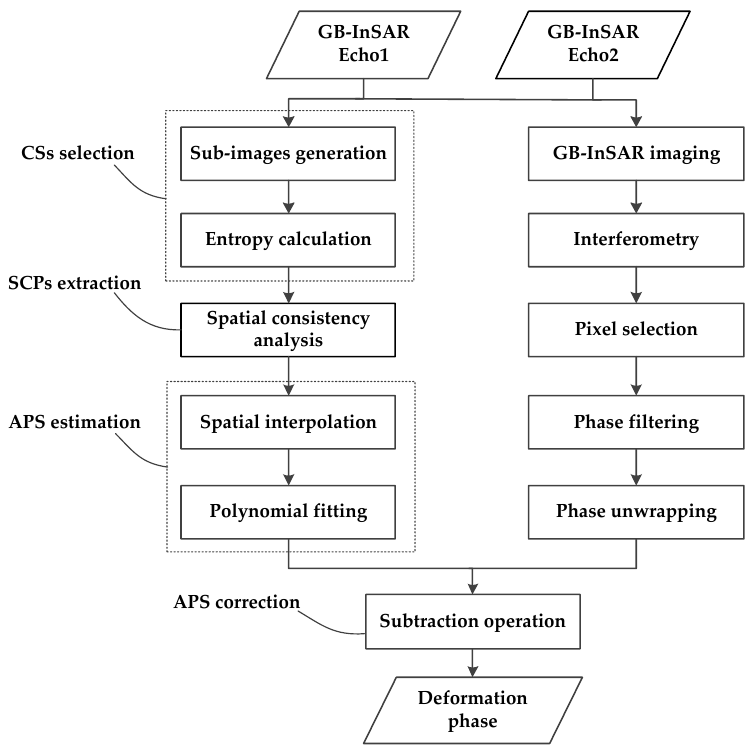
Figure 4. Time- and space-varying atmospheric phase correction algorithm flowchart.